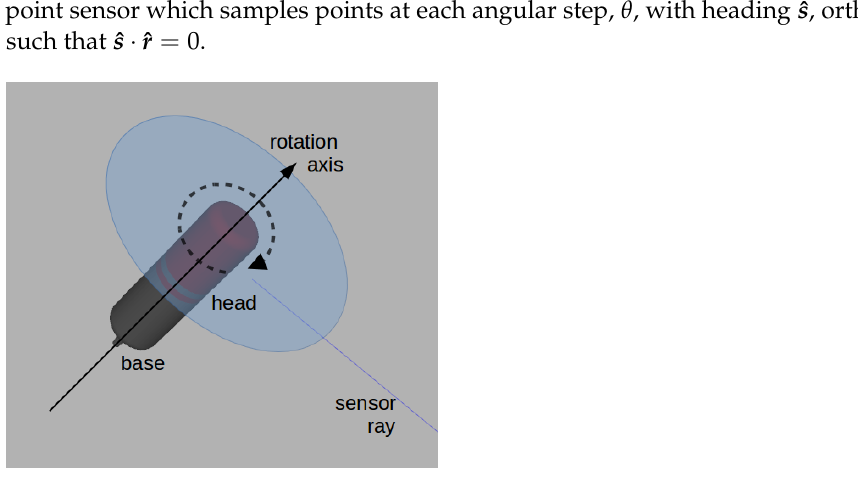
Figure 1. An example of profiling sensor with a single ray connected to a moving head.